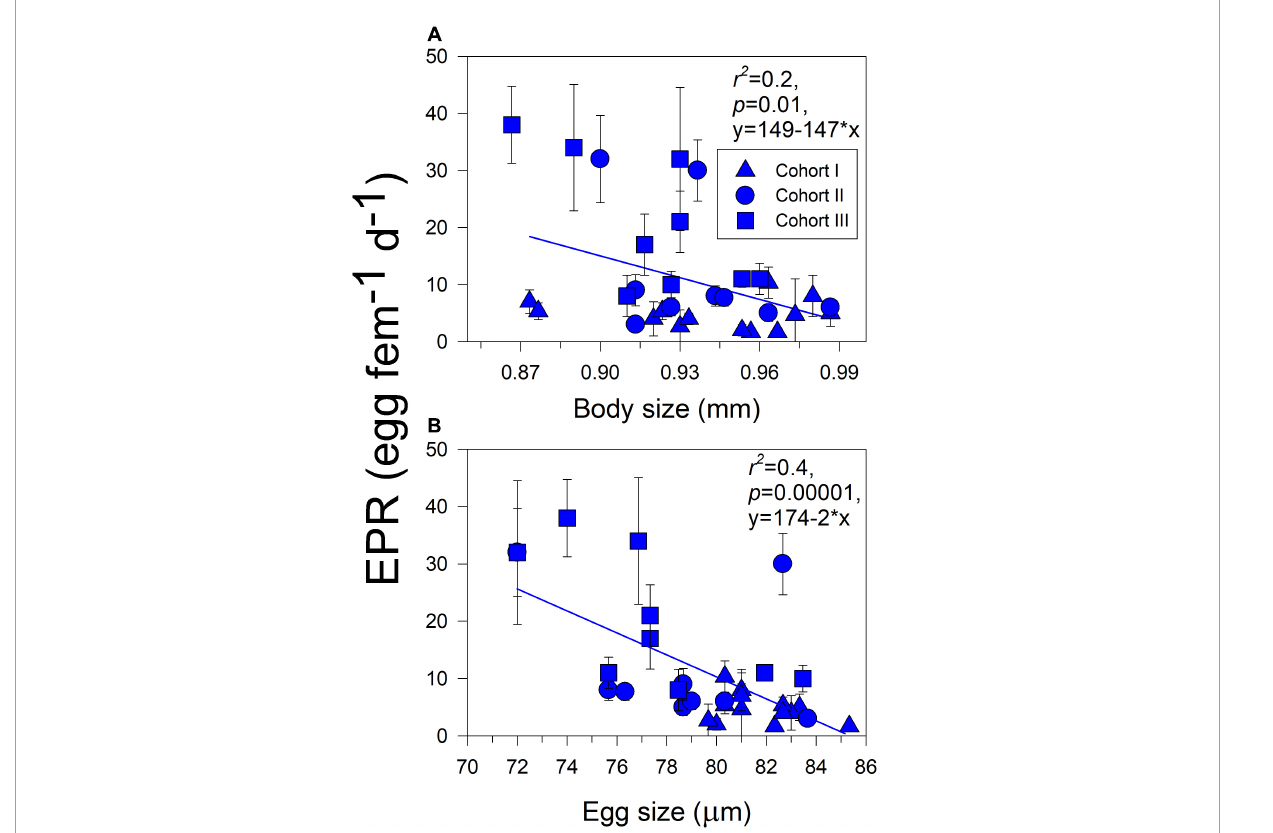
FIGURE3 Correlations (i.e., trade-offs) between parental (A) and offspring (B) traits with reproductive trait in the estuarine A. tonsa population. Dots represent the average ( ± SD) value of each trait at a given sampling survey.